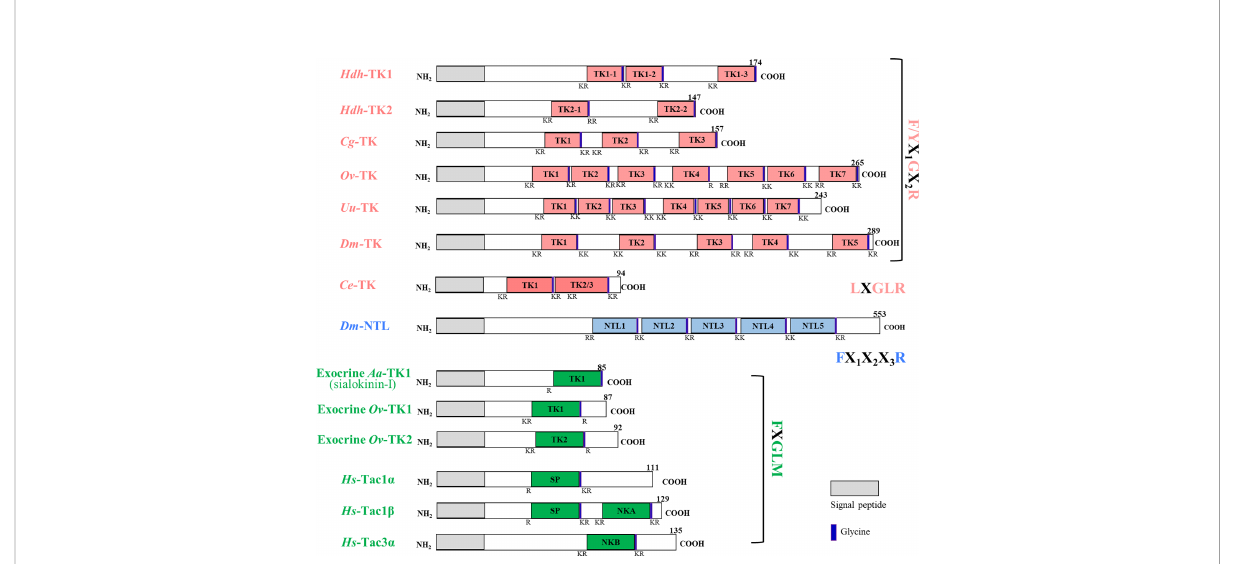
FIGURE 1 Schematic representation of protosome TK precursors and their human homologs. The signal peptide and glycine are denoted by the gray box and purple bar, respectively. The nucleotide and deduced amino acid sequences of the H. discus hannai TK precursors, Hdh -TK1 and Hdh -TK2, are available in Supplementary Figures 1A, B, respectively. Supplementary Table 1 provides information on the